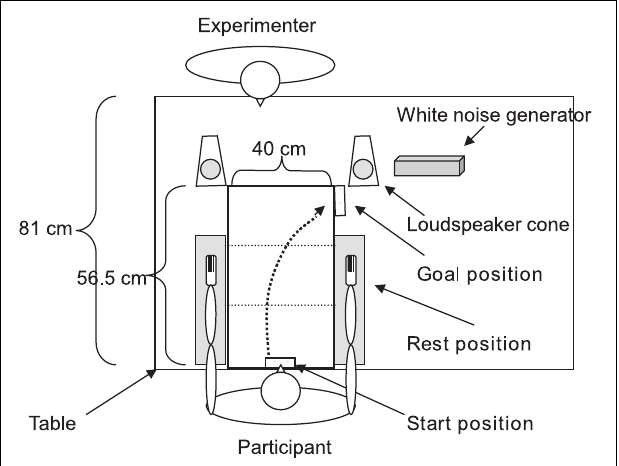
FIGURE 1 | Experimental set-up. The participant is depicted with both hands/arms at the resting positions.